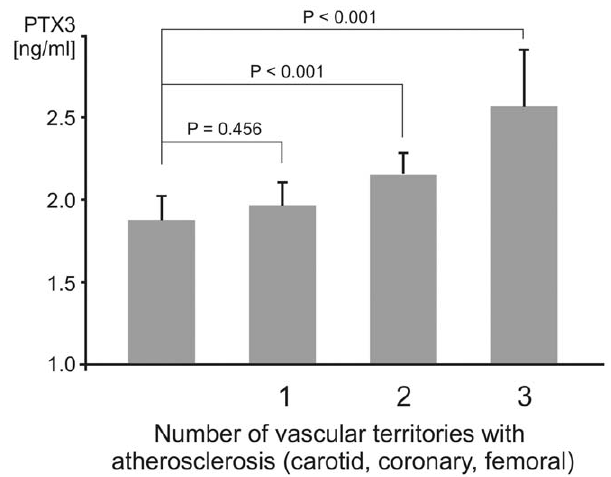
Figure 2. PTX3 level according to the number of vascular territories involved in the atherosclerosis process (Bruneck Study). Presence of atherosclerosis was determined by high-resolution ultrasound in the (common and internal) carotid (one territory) and femoral arteries (one territory), and on clinical grounds in the coronary arteries (clinically overt CHD, one territory). PTX3 levels were expressed as age and sex adjusted geometric means. Whiskers represent the 95% confidence interval (CI). P value for trend , 0.001 (analysis adjusted for sex and age) and P=0.003 (analysis adjusted sex, age, HDL and LDL- cholesterol, diabetes, smoking, hypertension, body mass index and waist circumference). Post hoc P values for comparisons between groups were calculated by the Dunnett